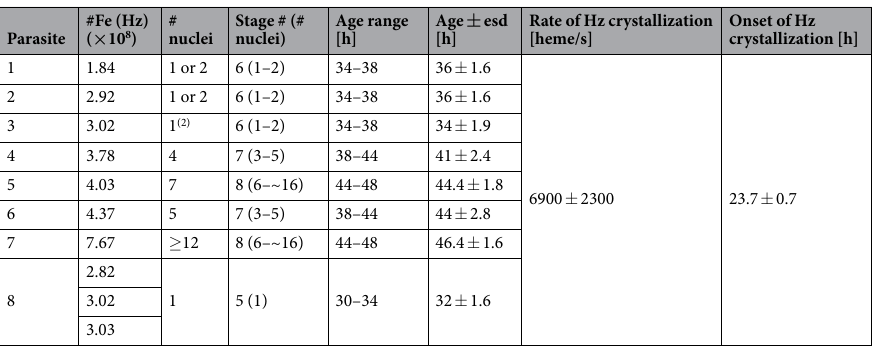
Table 1. In vivo estimate of heme crystallization rate. Shown in the 2 nd column are the total amounts of Fe atoms measured in the hemozoin crystals for the eight different parasites. The axial and in-plane alignment procedure was used to obtain the amounts of Fe for parasites 1–7, and for parasite 8 in its top row. The second Fe estimate for parasite 8 (middle row) was obtained from the 3D segmentation and fluorescent modeling alignment, and the third estimate (bottom row) from the volume of the crystals was obtained directly from the soft X-ray tomography (SXT) image. Note that the three different estimates for parasite 8 are close. The number of nuclei per parasite was obtained directly from the SXT image, and then converted to a stage based on published criteria 26 . Age was then estimated from this stage as described in Methods. Iron content vs. age were then plotted (Fig. 5), and the slope and y intercept of the best fitting line yielded the estimates for the heme crystallization rate and the onset of hemozoin (Hz)